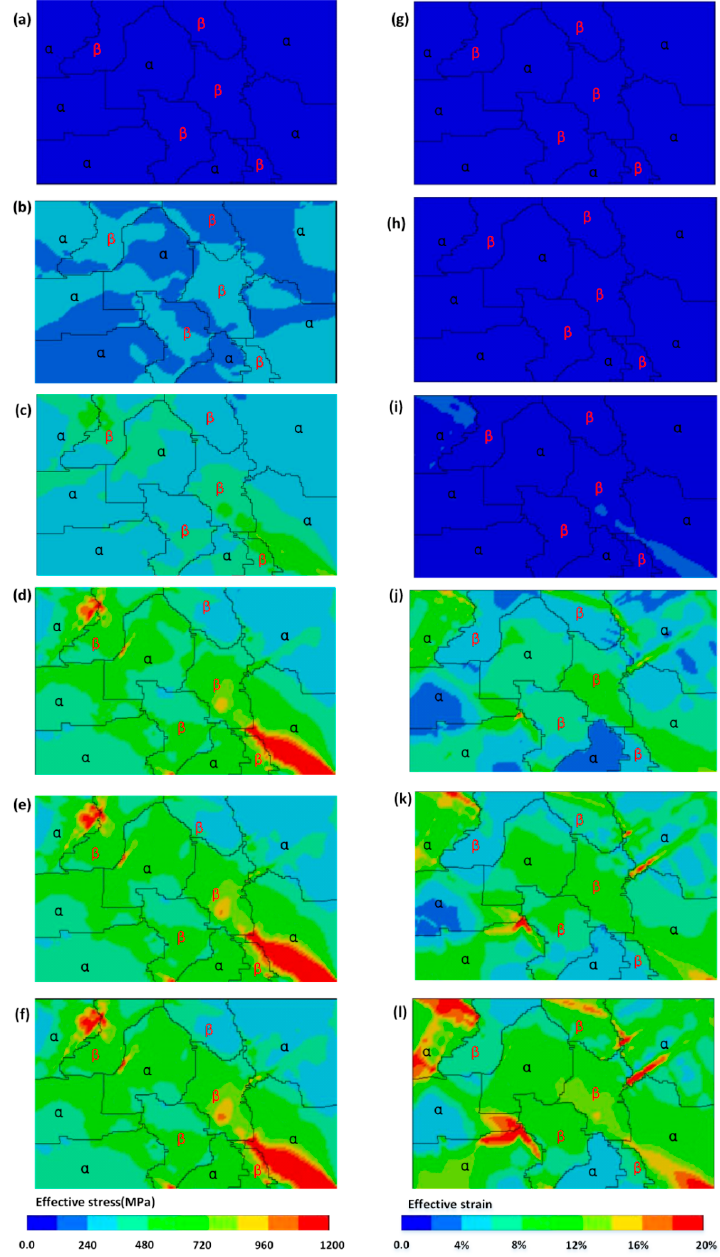
Figure 7. Stress and strain fields at macro strain = 0.1%, 0.7%, 1.2%, 4%, 7.8%, and 15.5%: ( a – f ) Von Mises effective stress field; ( g – l ) effective strain field.